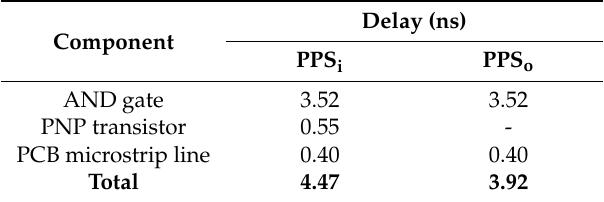
Table 2. Theoretical PPS i and PPS o delays, but AND gate delay is obtained by and oscilloscope measurement.